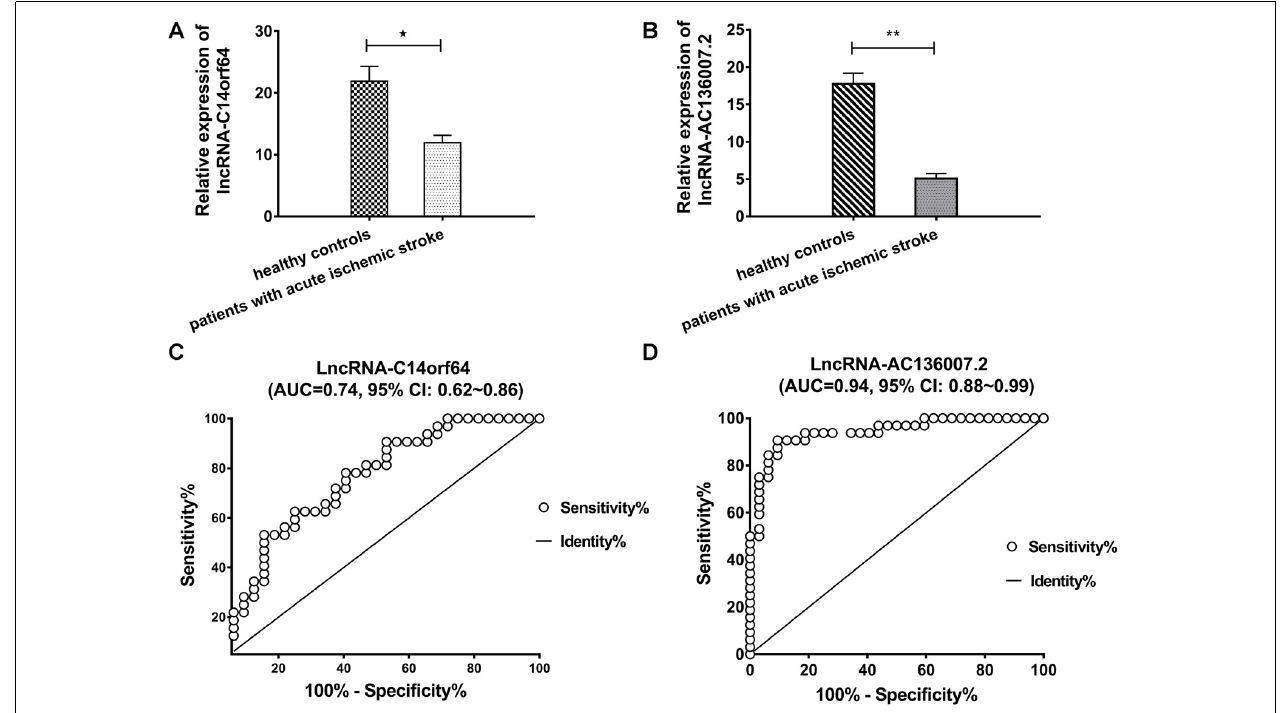
FIGURE 4 | Real-time polymerase chain reaction (RT-PCR) analysis of lncRNA expression and receiver operating characteristic (ROC) curves measuring the diagnostic efficiency of selected lncRNAs. (A) RT-PCR validation of the relative expression levels of lncRNA-C14orf64. (B) Relative expression levels of lncRNA-AC136007.2. (C) ROC curve for discriminating patients with AIS from healthy controls by lncRNA-C14orf64 had an area under curve (AUC) of 0.74 (95% CI, 0.62–0.86, sensitivity 0.63, specificity 0.75). (D) The ROC curve for discriminating patients with AIS from healthy controls via lncRNA-AC136007.2 had offered the greater diagnostic ability with an AUC of 0.94 (95% CI, 0.88–0.99, sensitivity 90.63, specificity 90.63). The measured RNA expression levels were normalized by GAPDH ( ∗ P < 0.05, ∗∗ P <